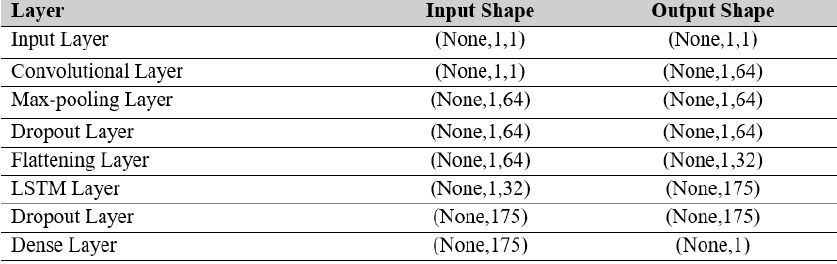
Figure 7. Working structure of proposed CNN-LSTM hybrid model.